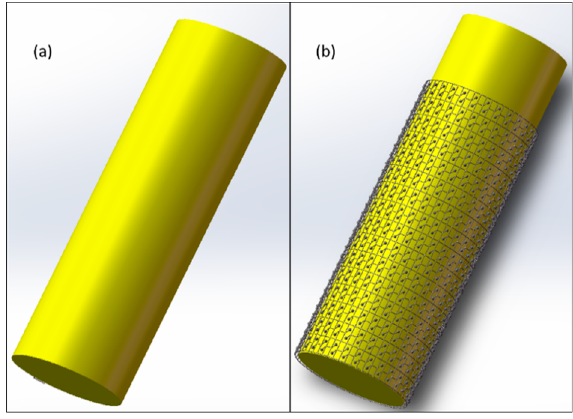
Figure 5. Ideal model of ( a ) PET fiber and ( b ) TMPP-modified PET fiber.